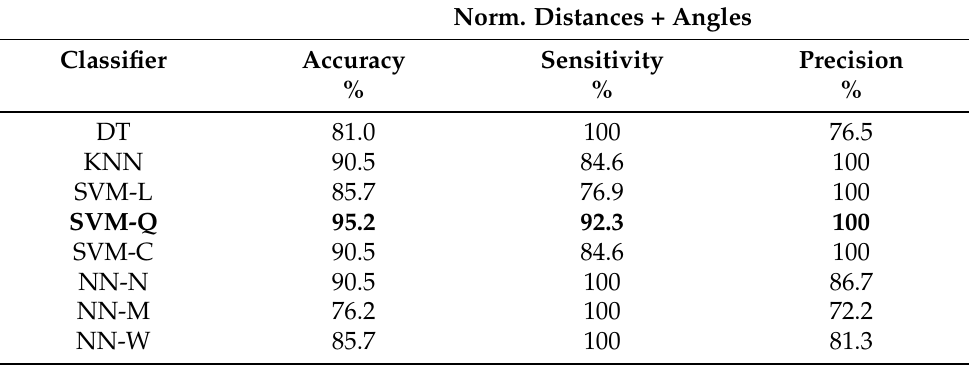
Table 4. Classification results when the combination of normalized distances ( D d , i ) and angles ( A a , i ) was used as a feature vector. The classifier providing better performance is highlighted in